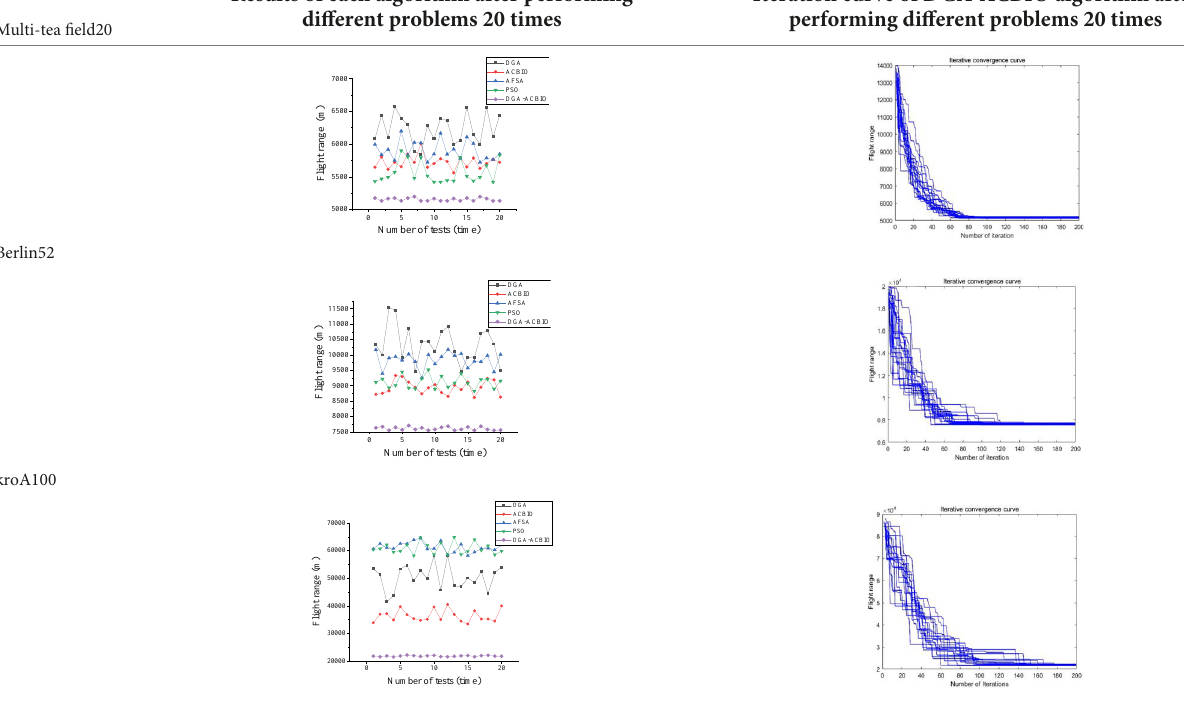
TABLE 4 Simulation results of each algorithm and iterative performance curve of DGA-ACBIO. Results of each algorithm after performing Iteration curve of DGA-ACBIO algorithm after different problems 20 times performing different problems 20